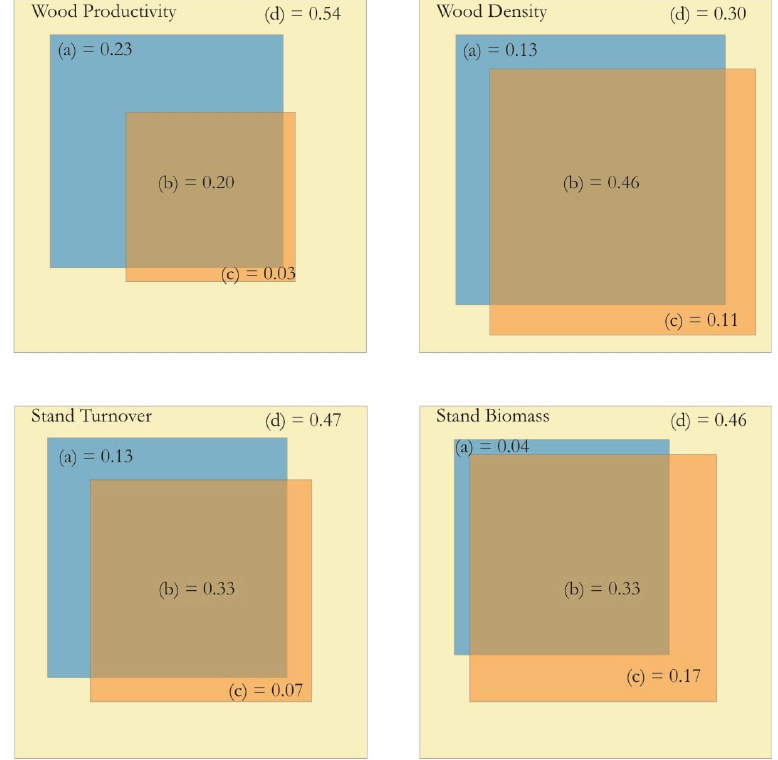
Fig. 15. Variation partitioning Venn diagrams representing the fractions of unique contribution of (a) environmental/edaphic and (c) spatial components to Basin-wide variations in Amazon forest above-ground wood productivity, stand-level wood density, stand tree turnover rates and biomass. Fraction (b) represents the shared variation between the environmental components and (d) the residual (unexplained) variations of the multiple regression model involving the OLS predictors and the SEVM-02